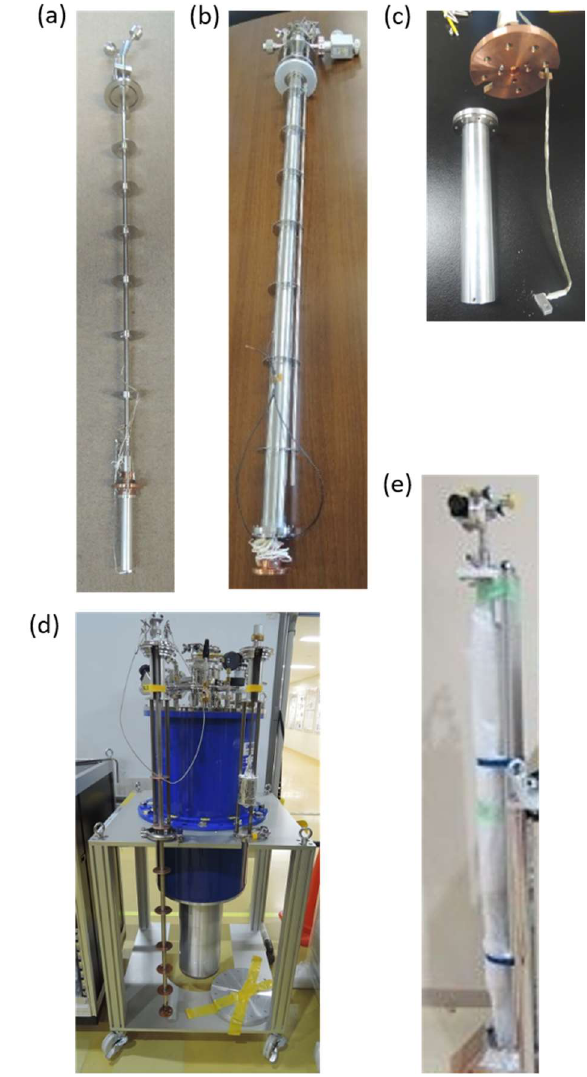
Fig. 8. (a)Sample stick for current application (Max 2 A, T < 500 K), (b)sample stick for voltage application (Max 1.5 kV, T < 500 K), (c)air-tight sample cell with electrodes, (d) liquid He type 2K cryostat (Blue Cryo) (1.5 K < T < 300K), (e) dilution insert (60 mK with the Blue Cryo)